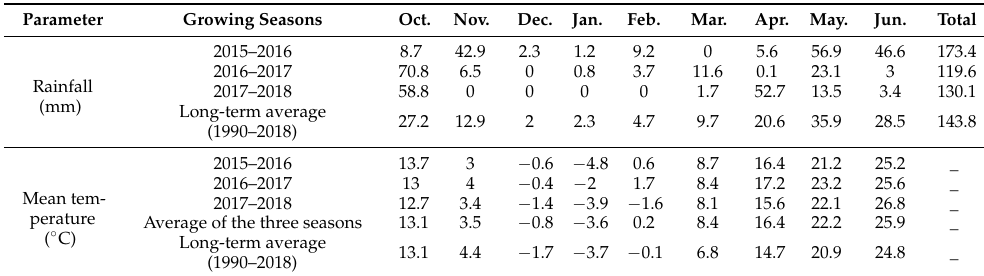
Table 1. Monthly precipitation and temperature for the winter wheat growing seasons from 2015 to 2018 and the long-term average from 1990–2018.